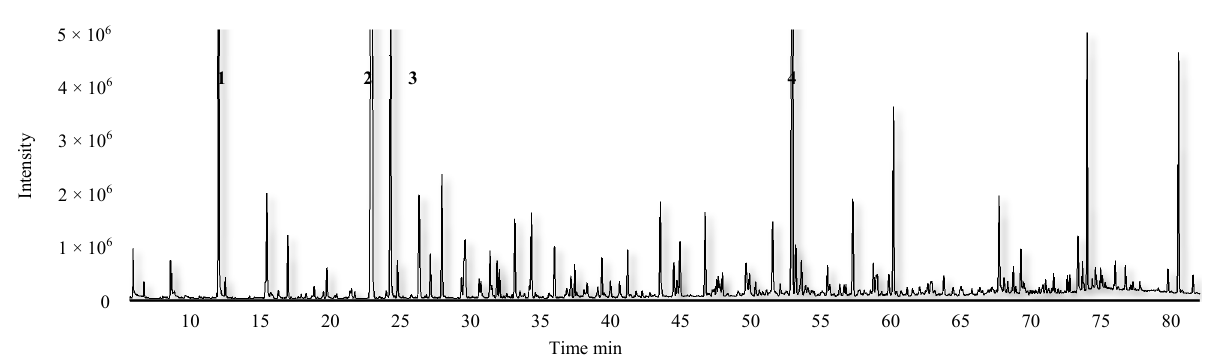
Figure 2. Total ion chromatograms of GC-MS in Dr. Guyot pear. Note: 1, butyl acetate; 2, hexyl acetate; 3, cyclohexanone (internal standard); 4, (E,E)- α -farnesene.